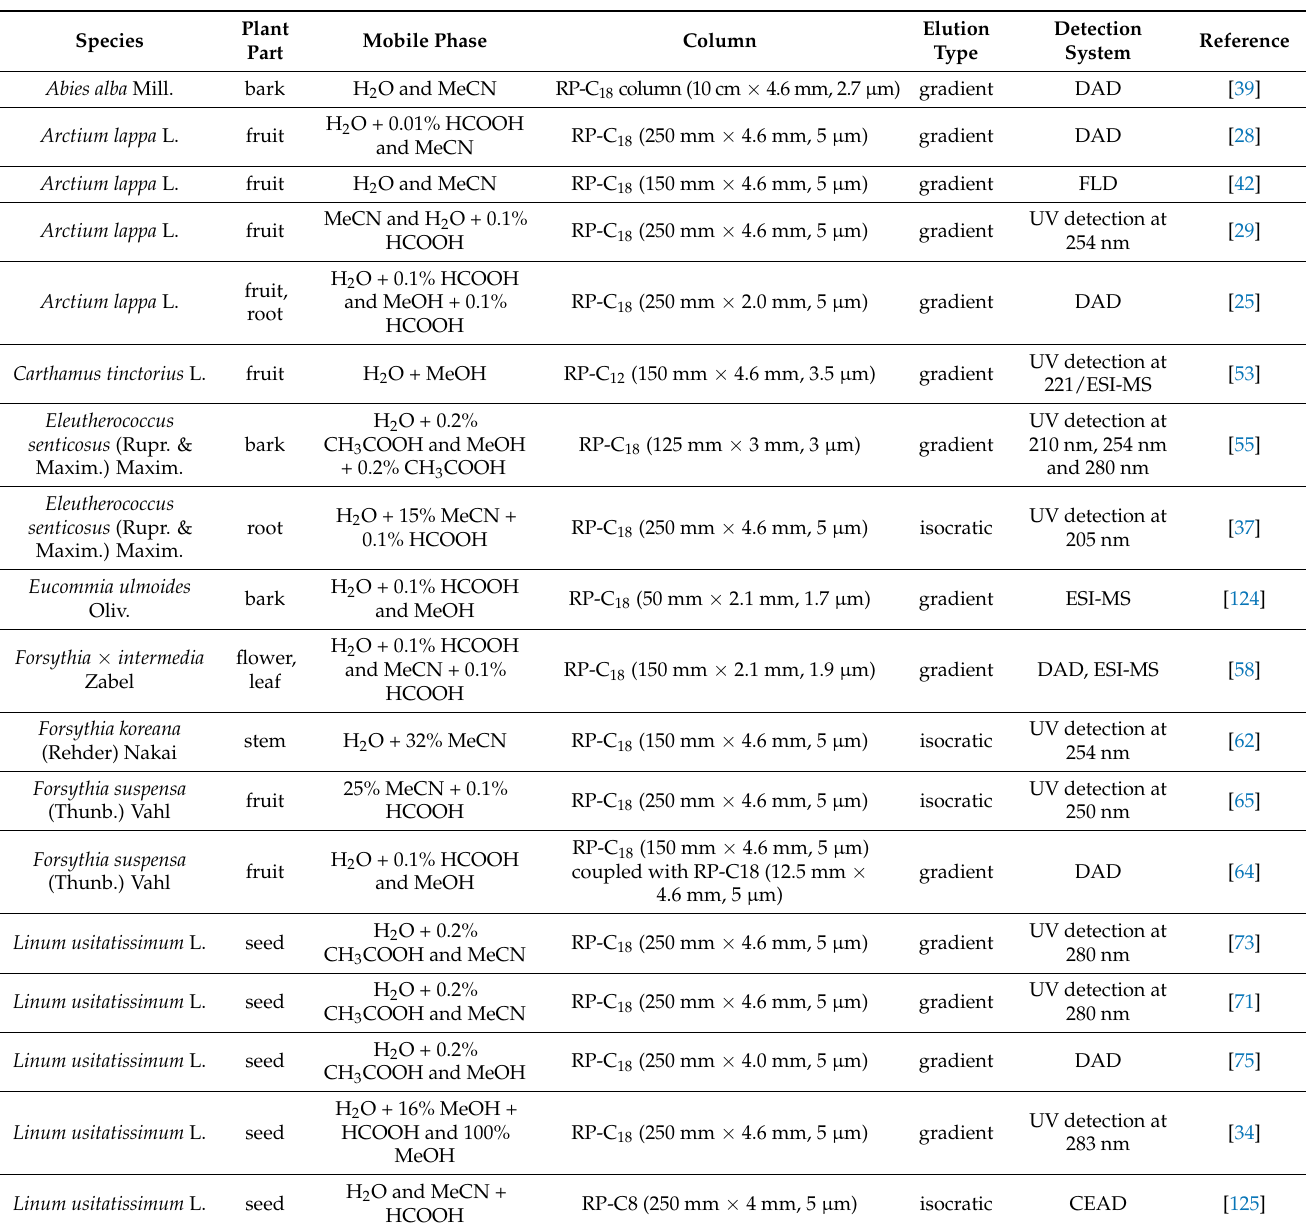
Table 2. HPLC methods used in the analysis of